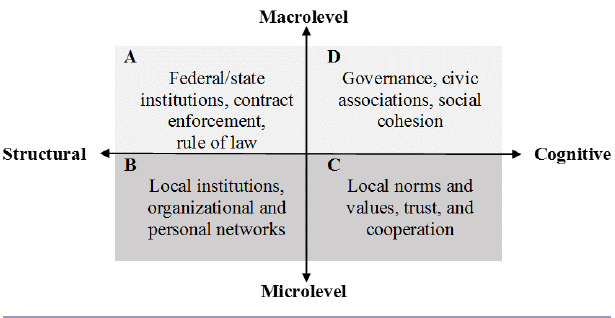
Fig. 1 . Dimensions of social capital by level and type. Quadrants A, B, and C represent the dimensions of social capital operationalized in this study (adapted from Grootaert and van Bastelaer